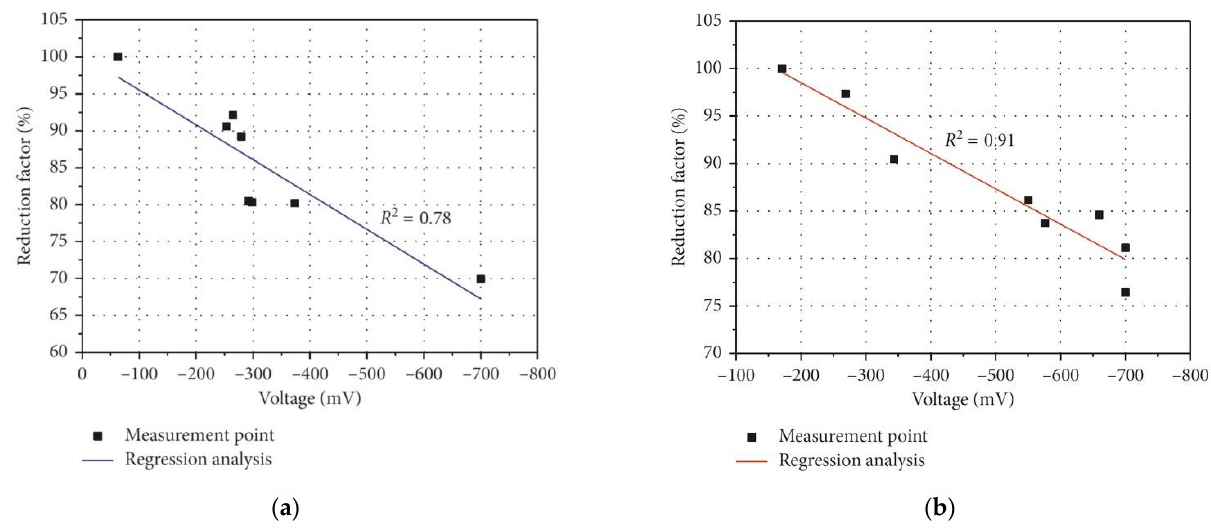
Figure 4. Relationship between the performance degradation factor and average potential difference in terms of voltage: ( a ) flexural failure type beams and ( b ) shear failure type beam.